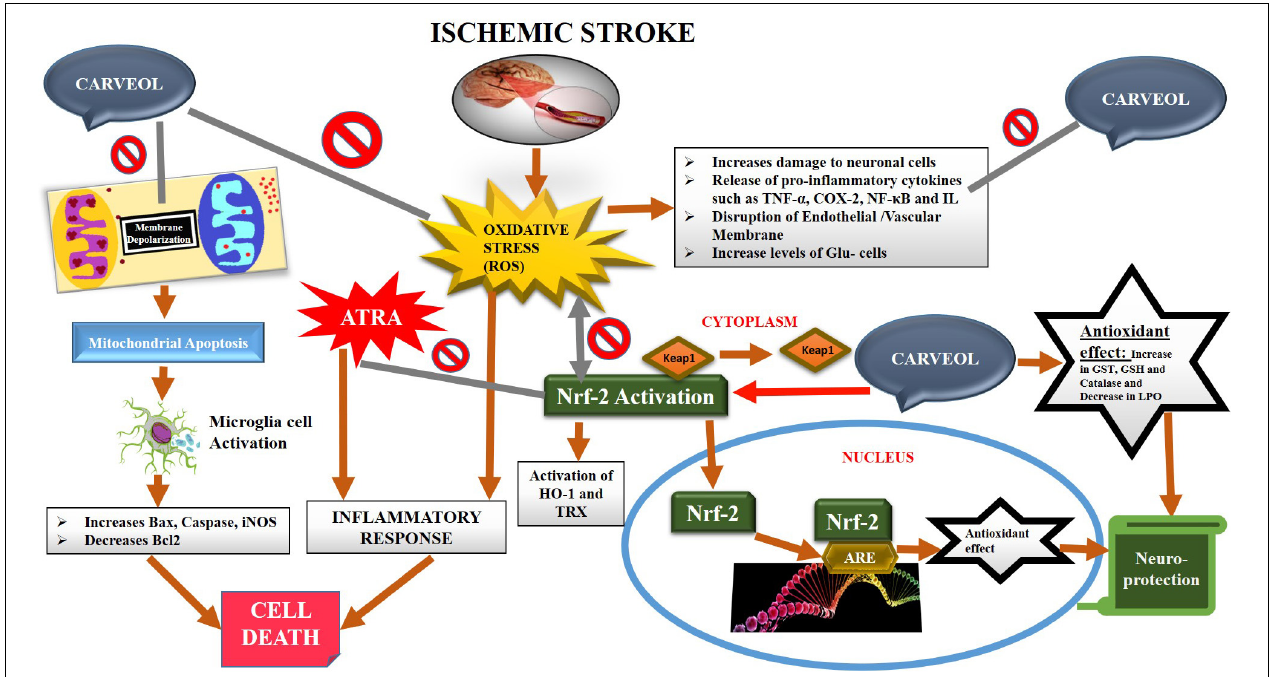
FIGURE 10 | The graphical representation indicates and elaborates on the underlying antioxidant and anti-inflammatory mechanisms of carveol against the MCAO-induced brain injury. TABLE 2 | Docking scores and hydrophobic interactions of retanoic acid and carveol with Keap-1. Inhibitor Docking score Hydrogen bonds ( < 3.5 Å) Amino acid Amino acid atom Ligand atom Distance (Å) Retanoic Acid 54.19